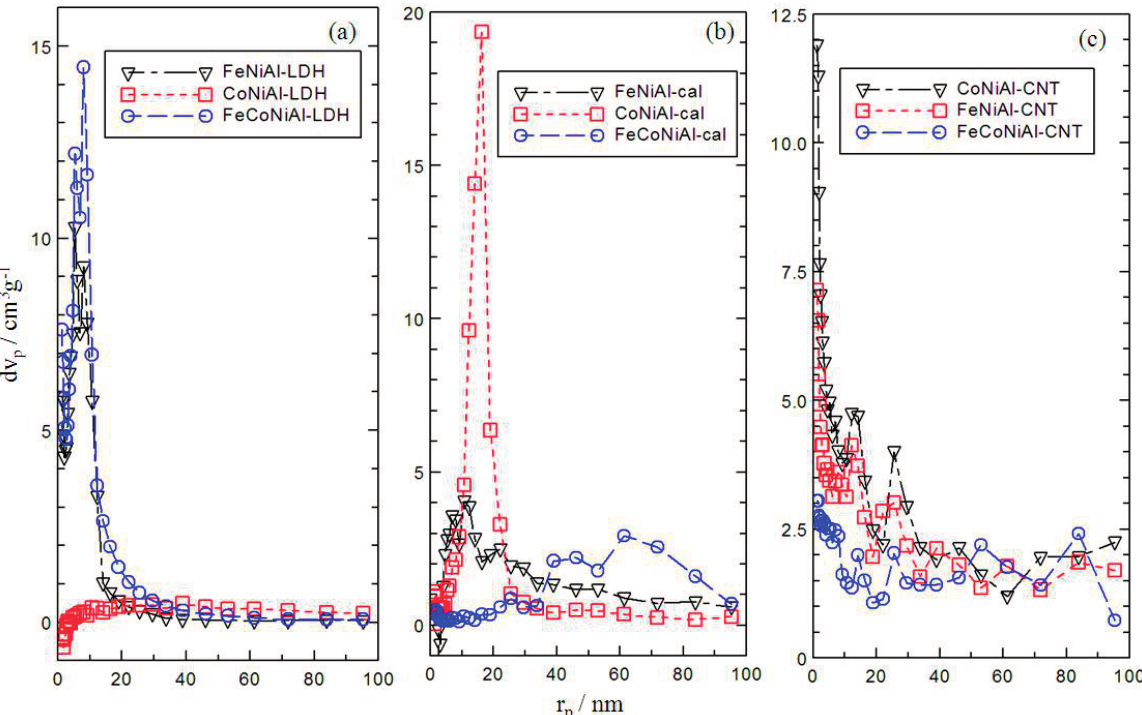
Figure 4. Pore size distribution of LDH ( a ) calcined LDH ( b ) and CNT over calcined LDH ( c